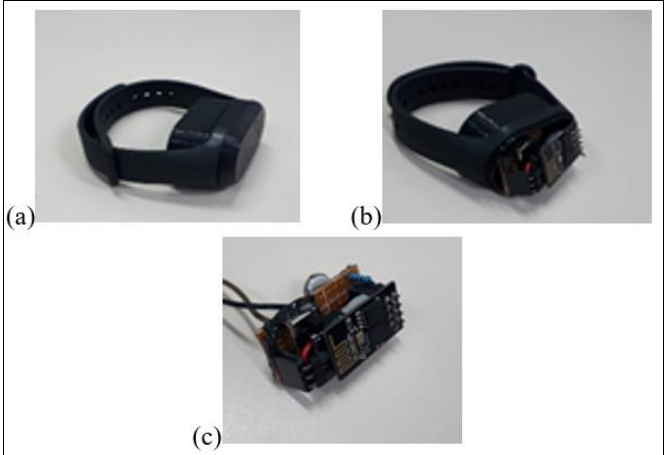
Figure 4: Vibrating bracelets. (a) closed bracelet; (b) bracelet with the apparent internal circuit; (c) circuit board that connects ESP01, battery and motor.